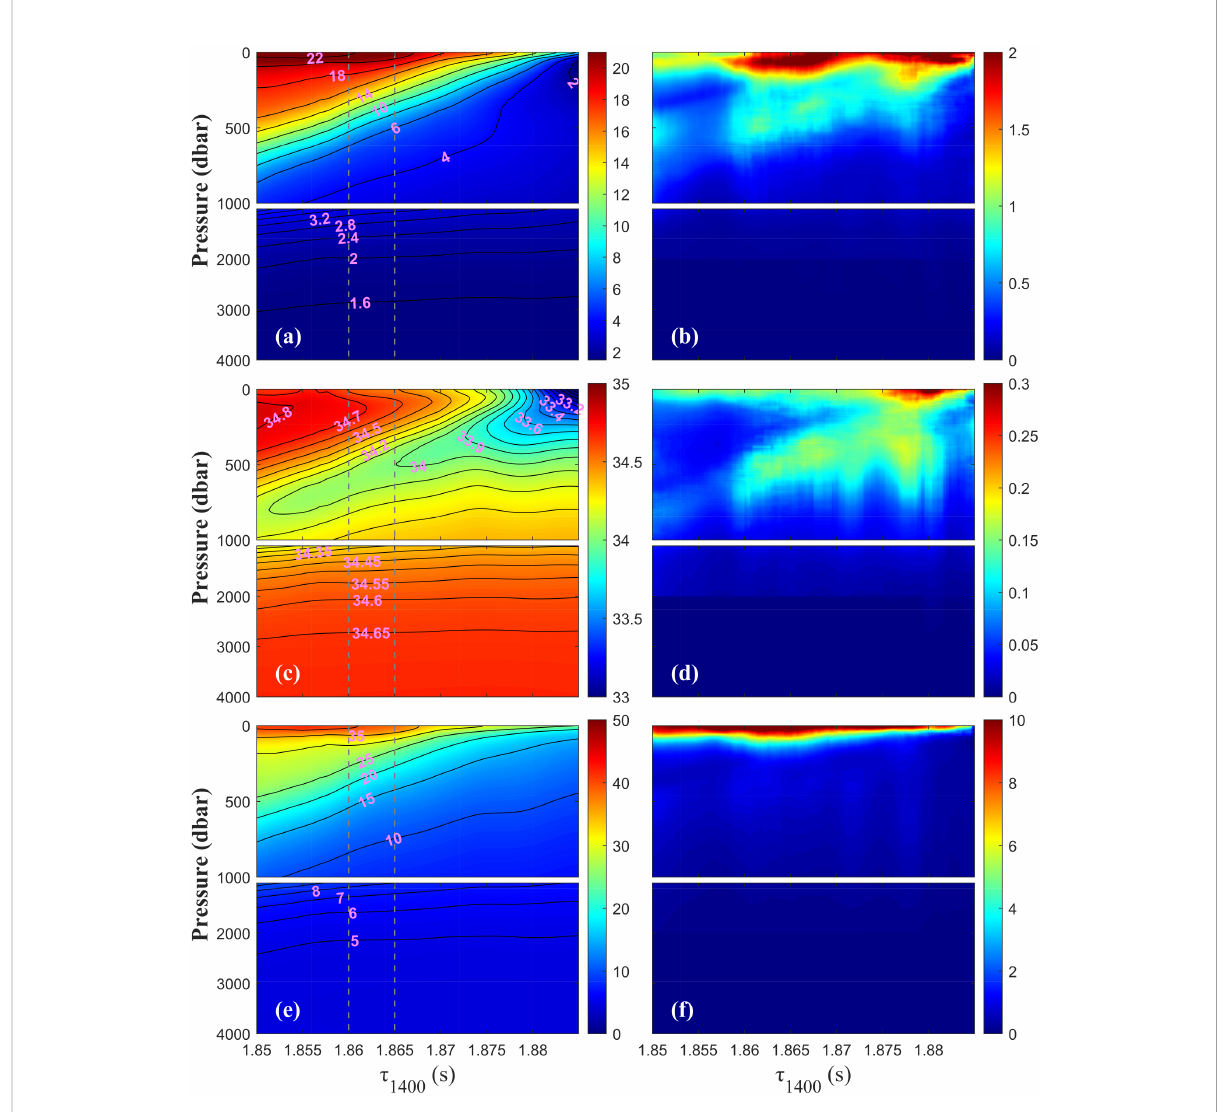
FIGURE 2 Gravest empirical mode (GEM) fi elds for (A) temperature, (C) salinity, and (E) speci fi c volume anomalies in the Kuroshio Extension System Study (KESS) area and their root mean square difference (RMSD) ( B , D , and F , respectively). Gray dashed lines frame the Kuroshio